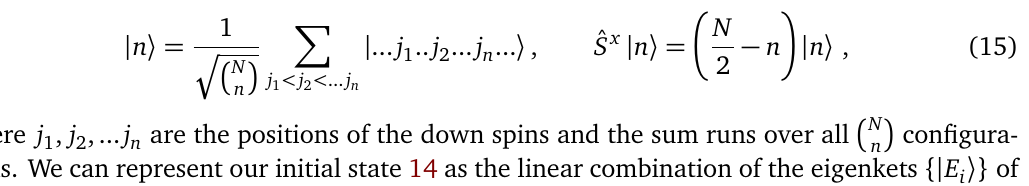
( m = ± l ) , P ( m = 0 ) , for the respective final l l 2